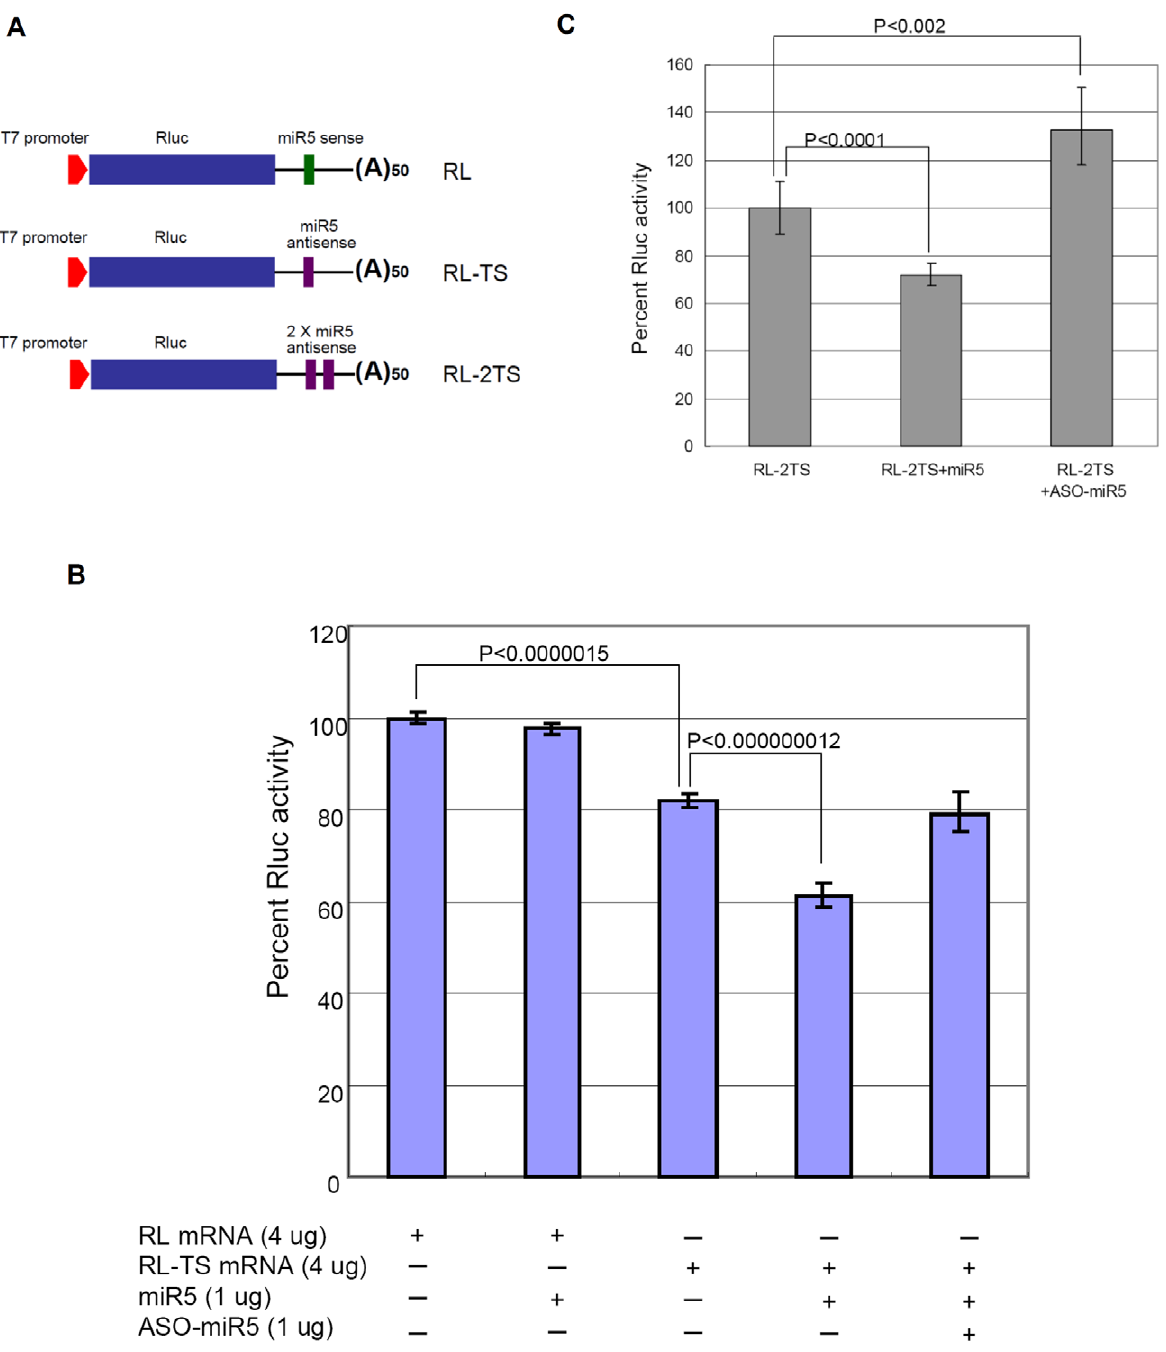
Figure 6. miR5 inhibits Rluc mRNA expression in Giardia by binding to the putative target site at 3 9 -UTR. ( A ) Diagram of the RL, RL-TS and RL-2TS reporter constructs. A copy of the miR5 sense sequence (green) and one (TS) or two (2TS) copies of the miR5 antisense sequence (purple) were each added to the 3 9 -UTR of Renilla Luciferase transcript as the negative control (RL) and transcripts carrying one and two potential miR5 target sites (RL-TS and RL-2TS), respectively. ( B ) Percentages of Luciferase activity expression in RL and RL-TS transcript transfected Giardia trophozoites. The Luciferase activity of RL was set at 100% and that of RL-TS was measured at 82%, suggesting action of endogenous miR5. The introduction of exogenous miR5 (1 m g) further represses RL-TS activity down to 61% without any detectable effect on RL expression. Inclusion of 1 m g of a 2 9 -O- methylated antisense of miR5 (ASO-miR5) with 1 m g of miR5 in the transfection recovers the Luciferase activity of RL-TS to the original 80%. The results and standard deviations were derived from three independent transfection experiments. The p-values indicated were calculated by two-tailed Student’s t -test. ( C ) Effects of miR5 and ASO-miR5 on the expression of RL-2TS. The presence of double target sites shows a little more exogenous miR5 repression ( , 30%) than that from the single target site shown in panel B. The introduction of ASO-miR5 without miR5 restores the expression of RL-2TS up to . 130% apparently by inhibiting the endogenous miR5 function. The results and standard deviations were from three independent transfection experiments. The p-values indicated were calculated by two-tailed Student’s t -test.